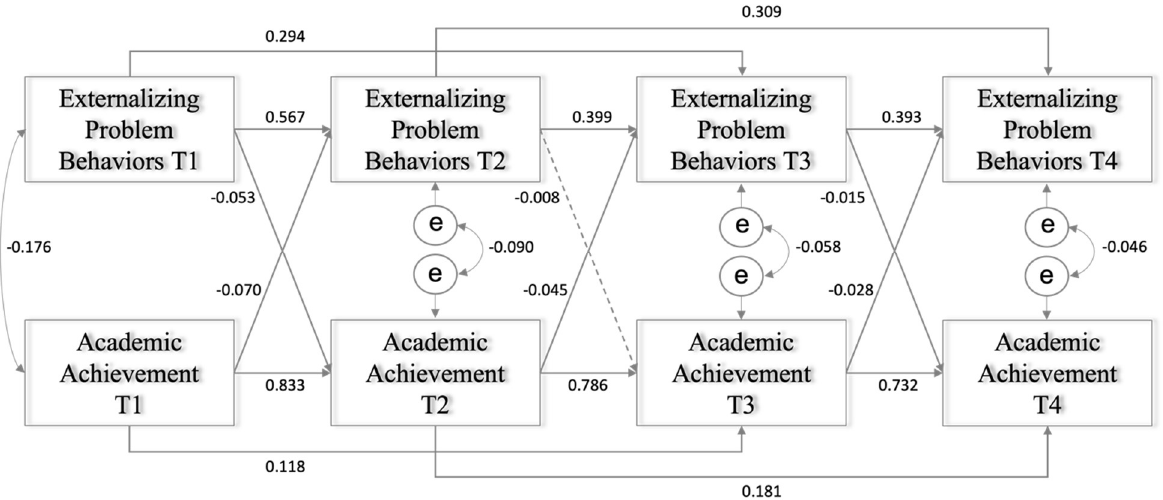
Figure 2. Transactions between externalizing problem behaviors and academic achievement (dot- ted lines indicate nonsignificant paths). lines indicate nonsignificant